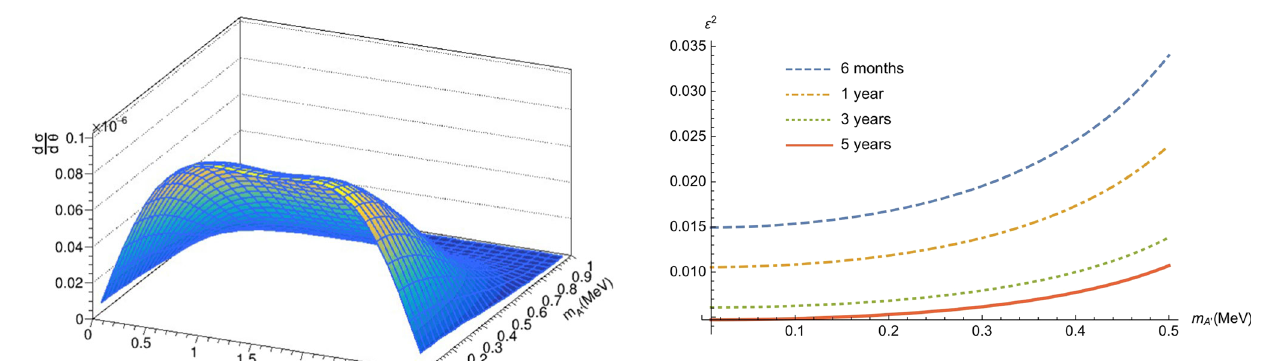
Fig. 3 Limits on dark photon from γ – γ collider. Orange solid line is constraint with γ – γ collider has a run-time of 5 years. The other three, blue dashed line is considered under 6-months’ run-time, brown dot dashed line is of 1-year operation and green dot line is 3 years run-time respectively. Obviously we can see that longer time scale gives more stringent constraint on dark